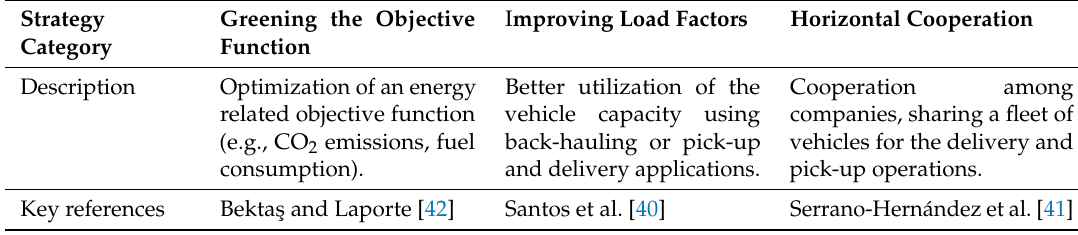
Table 3. Summary of energy optimization strategies in freight road